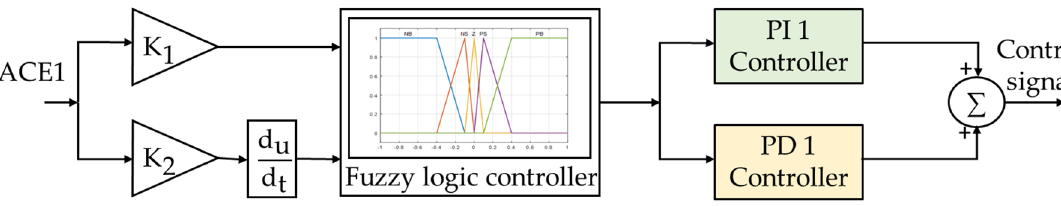
Figure 17. Block diagram of Fuzzy PI plus Fuzzy PD controller configuration equipped in area one. Figure 18. Block diagram of Fuzzy (PI + PD) controller configuration equipped in area one.